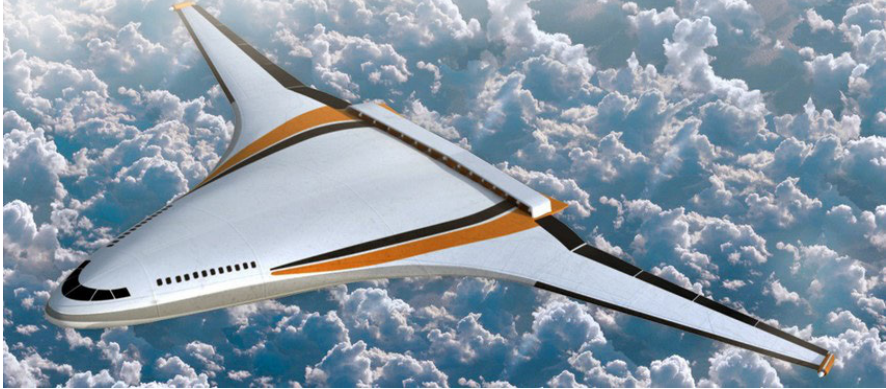
Figure 4. N3-X concept